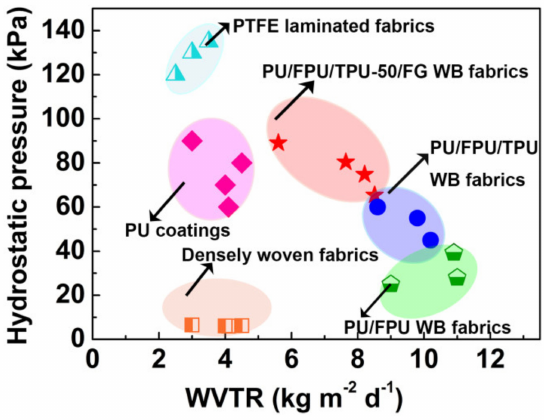
Figure 5. Comparison of waterproofness and breathability of WB